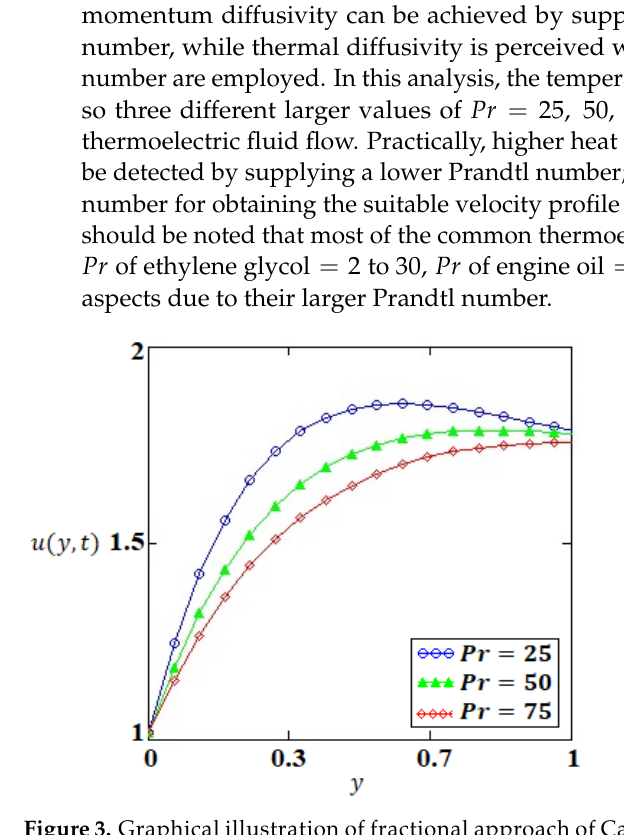
Figure 3. Graphical illustration of fractional approach of Caputo-Fabrizio with R 0 = 1, K 0 = 0.4, ZT 0 = 3.7, ω = 0.5, M = 0.5, α = 0.6, t = 1 for different Prandtl number values.